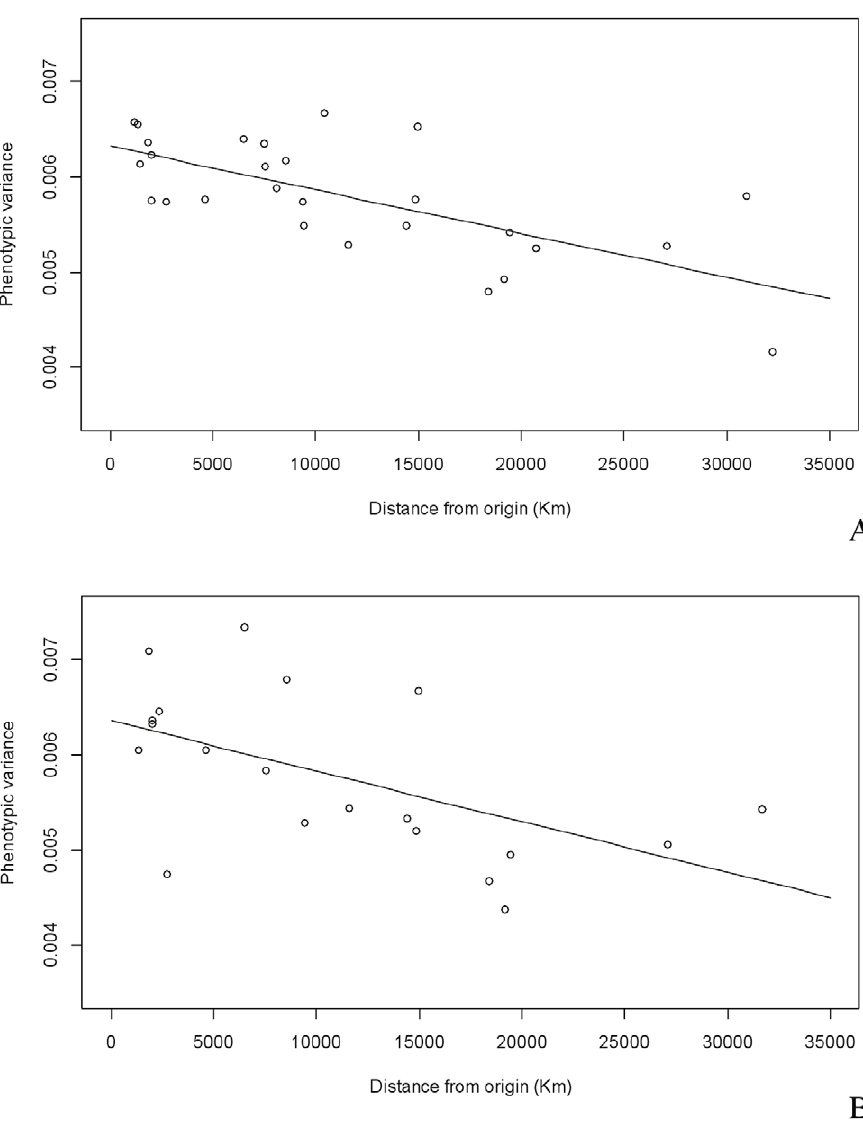
Figure 5. Out-of-Africa pattern. Plot of within-population phenotypic variance on distance from the sub-Saharan African centre of origin for males (A) (r 2 =0.466; p-value , 0.001) and females (B) (r 2 =0.305; p-value=0.012) (Table 5). The difference between males and females disappears when equal numbers of populations (i.e. 19) are used for males (r 2 =0.292; p-value=0.017) and females (r 2 =0.284; p-value=0.019) (Table 5).